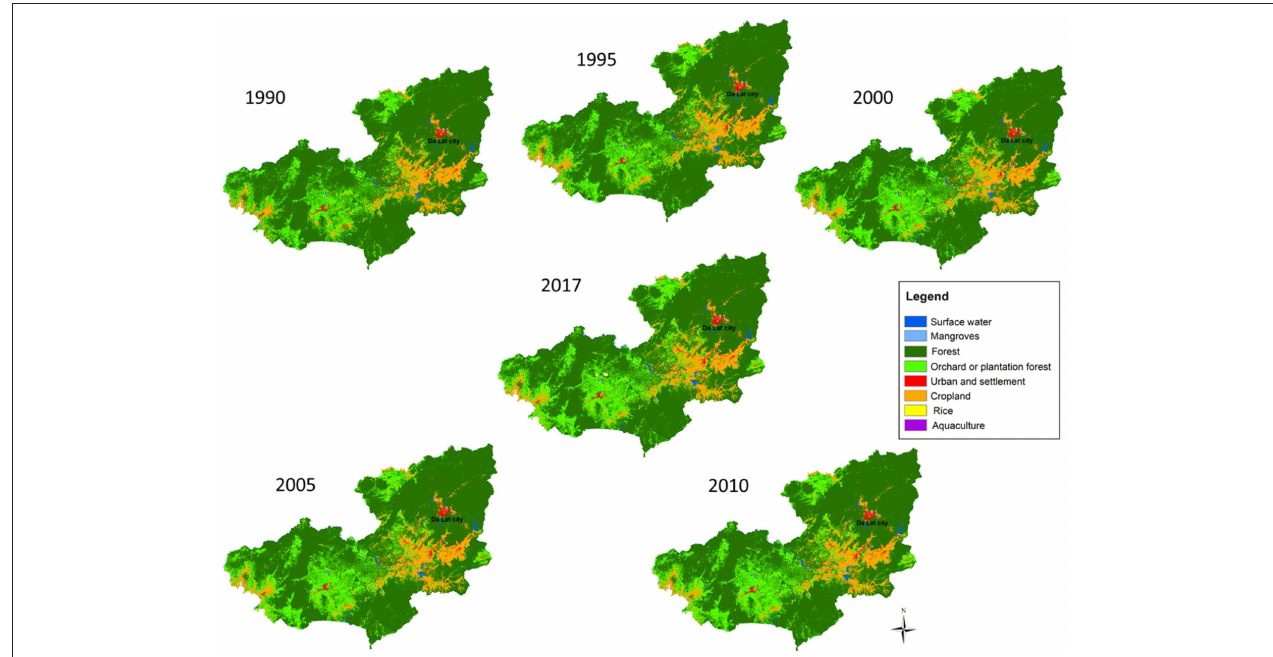
FIGURE 9 | Land cover change in Lam Dong with 5 year intervals from 1990 to 2017. The statistics can be found in Supplementary Table 3 .